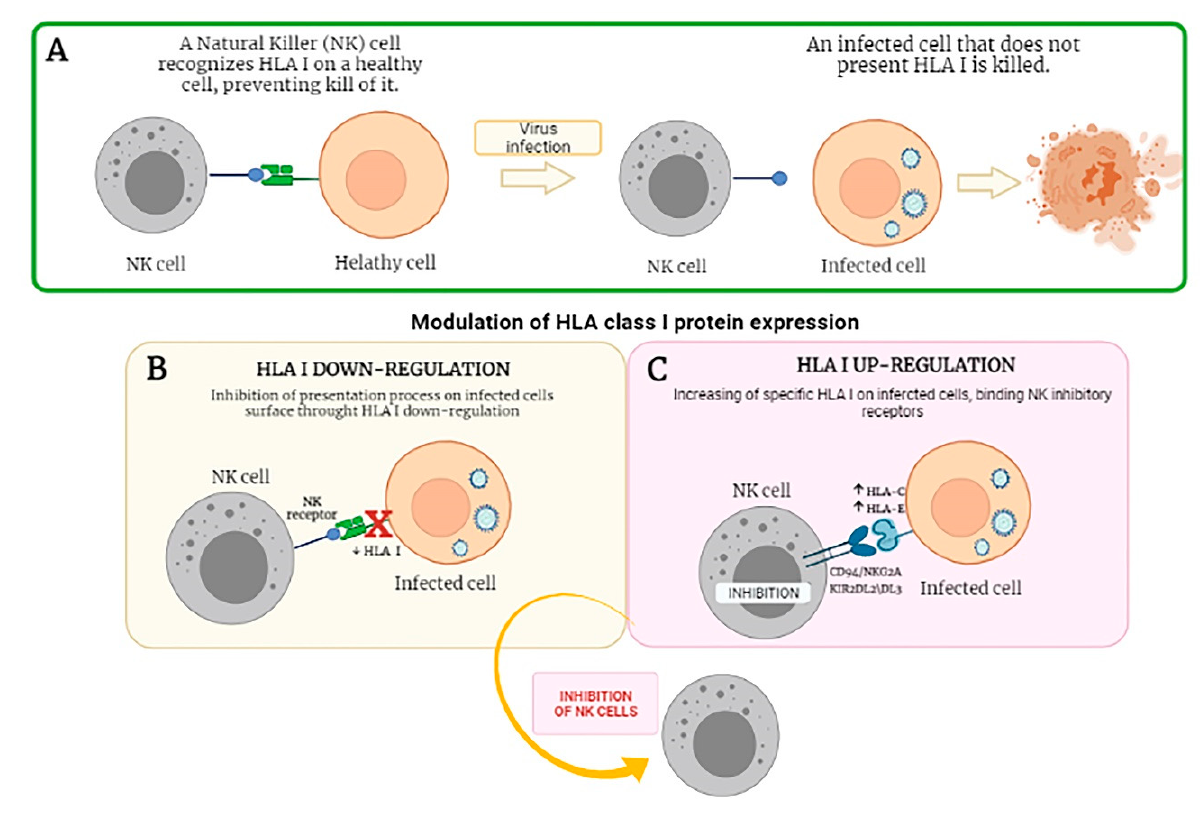
Figure 5. Representation of HLA-I dependent NK cells activation. NK cell response in presence of healthy and infected cells ( A ); NK cells response in presence of selective downmodulation ( B ) and upmodulation ( C ) of HLA-I protein expression by virus.